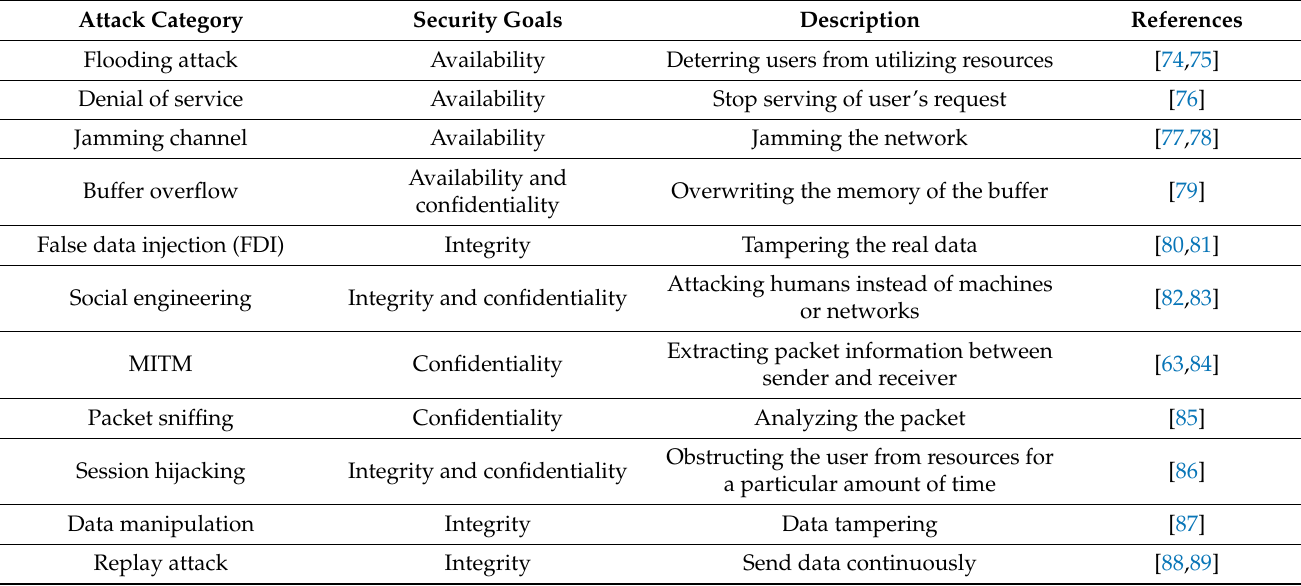
Table 7. Goals of security that have been jeopardized because of an